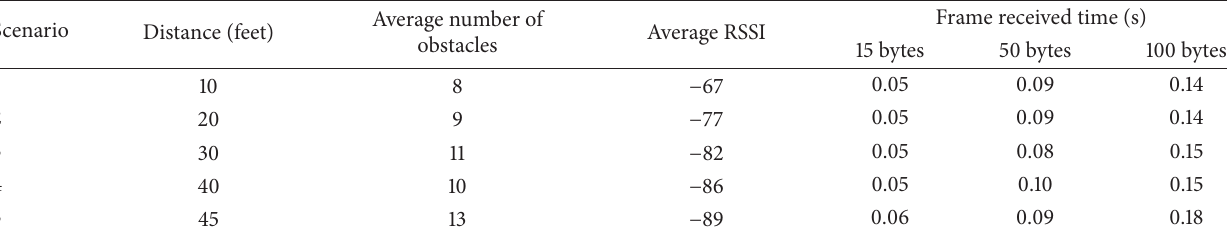
Table 11: Overall performance evaluation at various